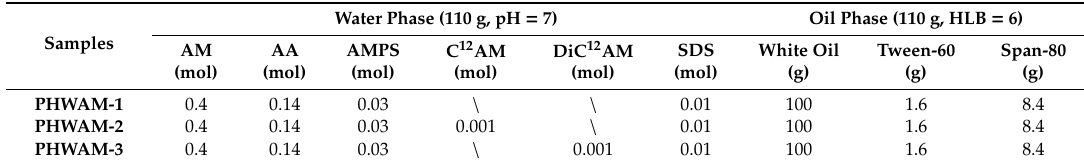
Table 1. The synthetic scheme of drag